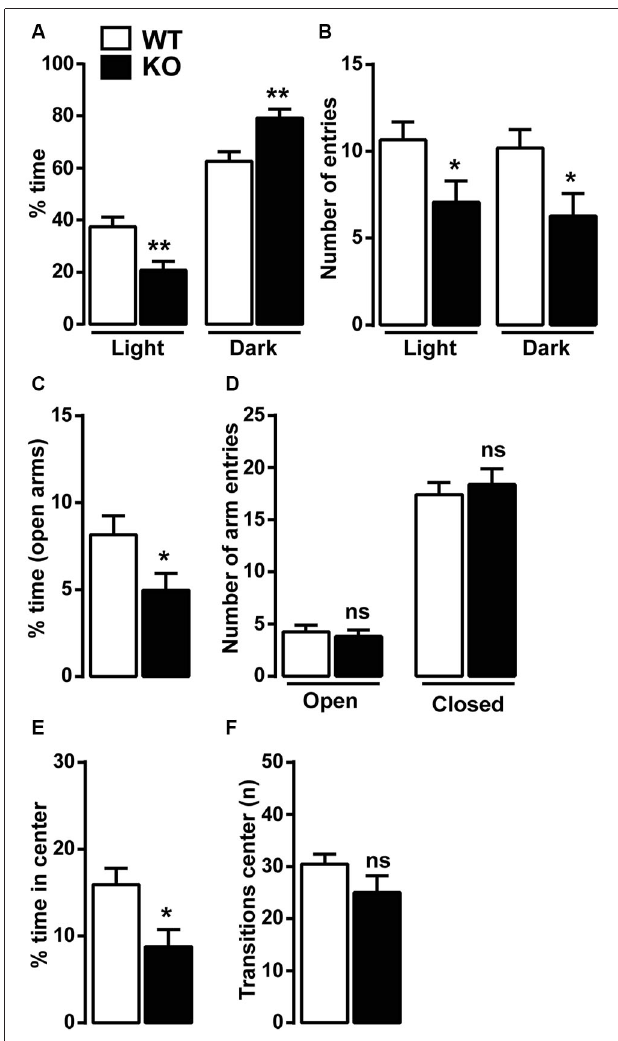
FIGURE 2 | Anxiety-like behavior in Ca v 3.2 deficient mice. Mice were tested in three anxiety-related behavioral paradigms: the ligh/dark conflict test, the elevated plus maze test (EPM) and the open field test. (A) Histograms show the percentage of time Ca v 3.2 KO ( n = 14) and WT mice ( n = 15) spent in the light and the dark compartments. (B) Histograms indicate the number of entries of Ca v 3.2 KO ( n = 14) and WT mice ( n = 15) in the light and the dark compartments. (A and B) Data (means ± SEM) were analyzed using Student’s t -test: * p < 0.05; ** p < 0.01. (C) Histograms show the percentage of time Ca v 3.2 KO ( n = 17) and WT mice ( n = 19) spent in the open arms of the EPM. Data (means ± SEM) were analyzed using Student’s t -test: * p < 0.05. (D) Histograms indicate the number of entries of Ca v 3.2 KO ( n = 17) and WT mice ( n = 19) in open and closed arms of EPM. Data (means ± SEM) were analyzed using student’s t -test: ns. (E) Histograms show the percentage of time Ca v 3.2 KO ( n = 14) and WT mice ( n = 15) spent in the center zone of the open field. Data (means ± SEM) were analyzed using student’s t -test: * p < 0.05. (F) Histograms indicate the number of transitions Ca v 3.2 KO ( n = 14) and WT mice ( n = 15) made in the center zone of the open field. Data (means ± SEM) were analyzed using student’s t -test: